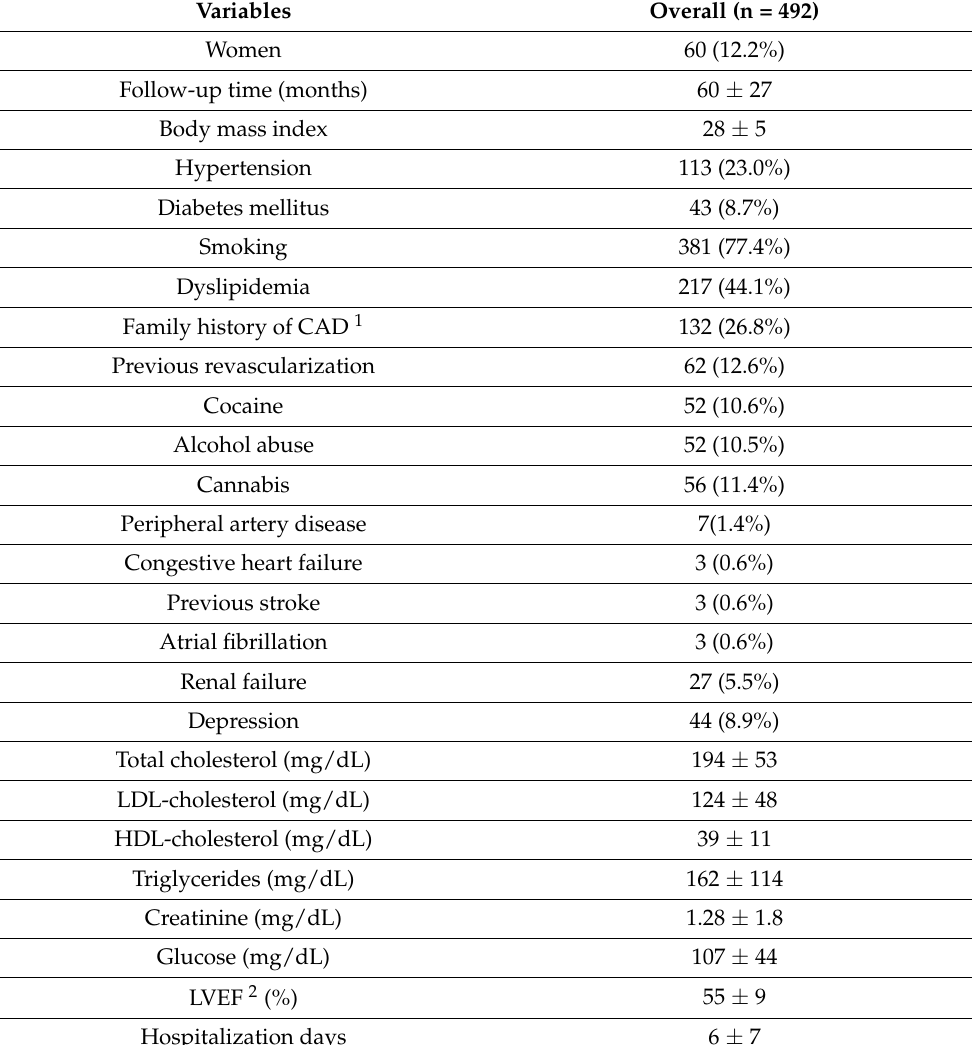
Table 1. Clinical characteristics of patients ≤ 40 years undergoing coronary